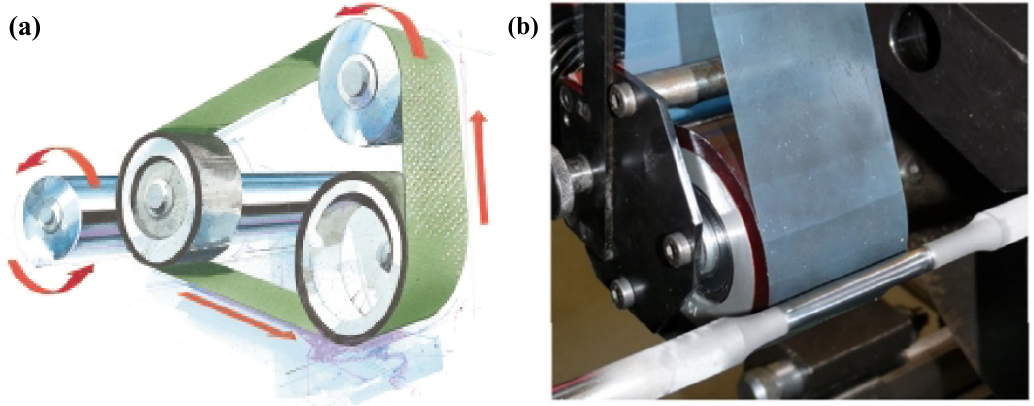
Figure 15. ( a ) Schematic diagram of a rotating abrasive film with controlled pressure against a rotating circular shaft [101]; Reprinted with permission from [101]; 3M. ( b ) Superfinishing of a cylindrical specimen following thermal spray coating with WC-CoCr coating [102]. Reprinted with permission from [102]; 2013 Elsevier.